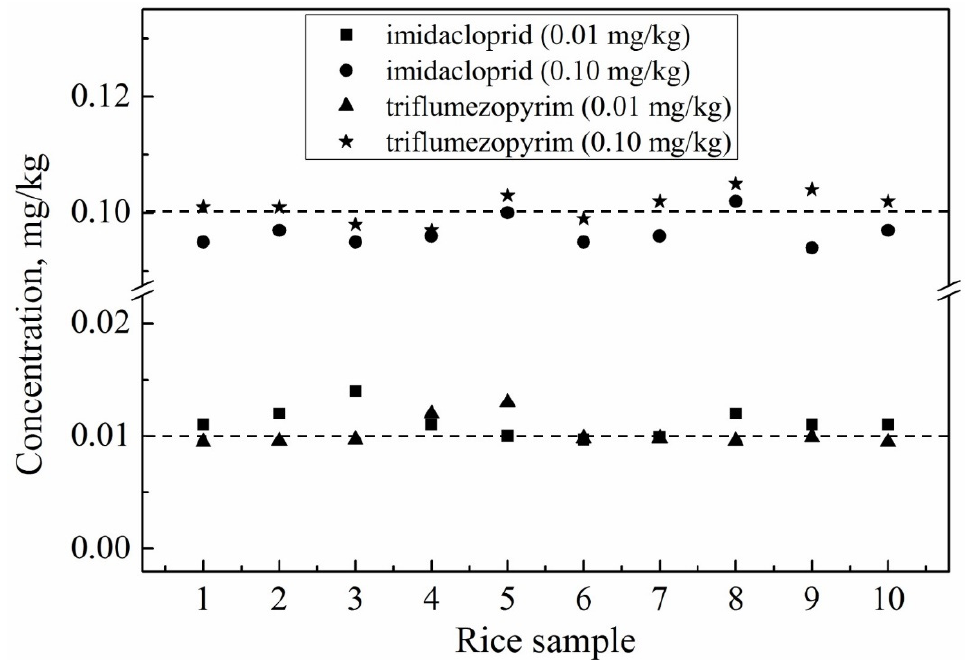
Figure 5. Residues of triflumezopyrim and imidacloprid in positive rice samples.